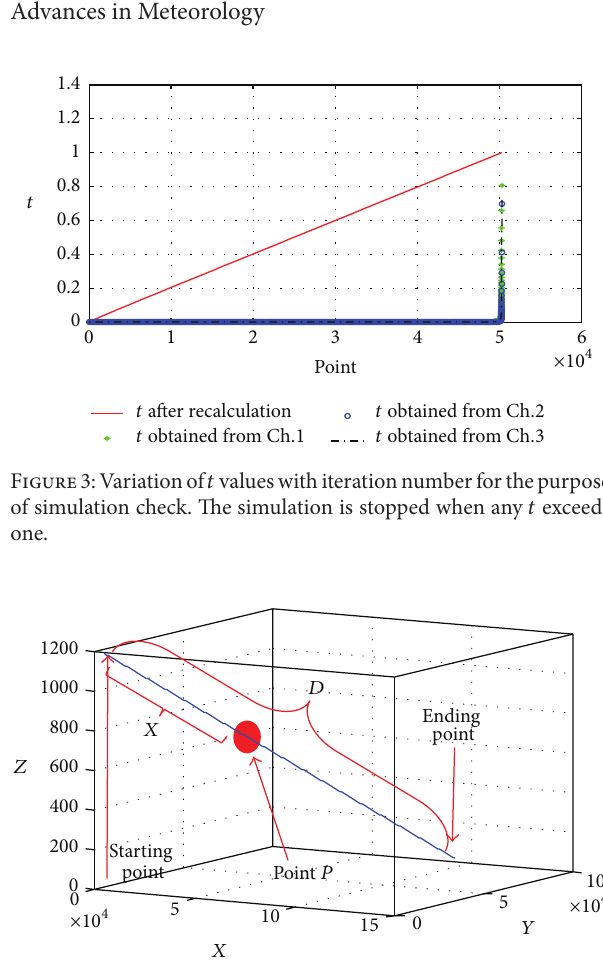
Figure 4: A linear path of simulated lightning leader.